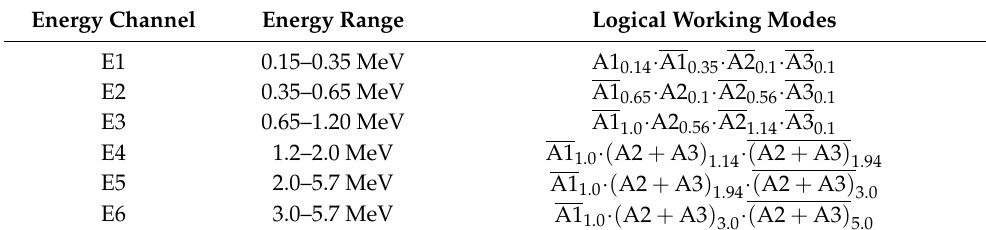
Table 3. Logical working modes of high-energy electron probe.